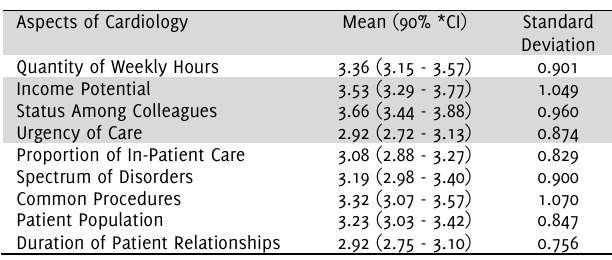
Table 3 . Student Understanding of Career-Related Factors in Canadian Cardiology Practice using a 5-point Likert